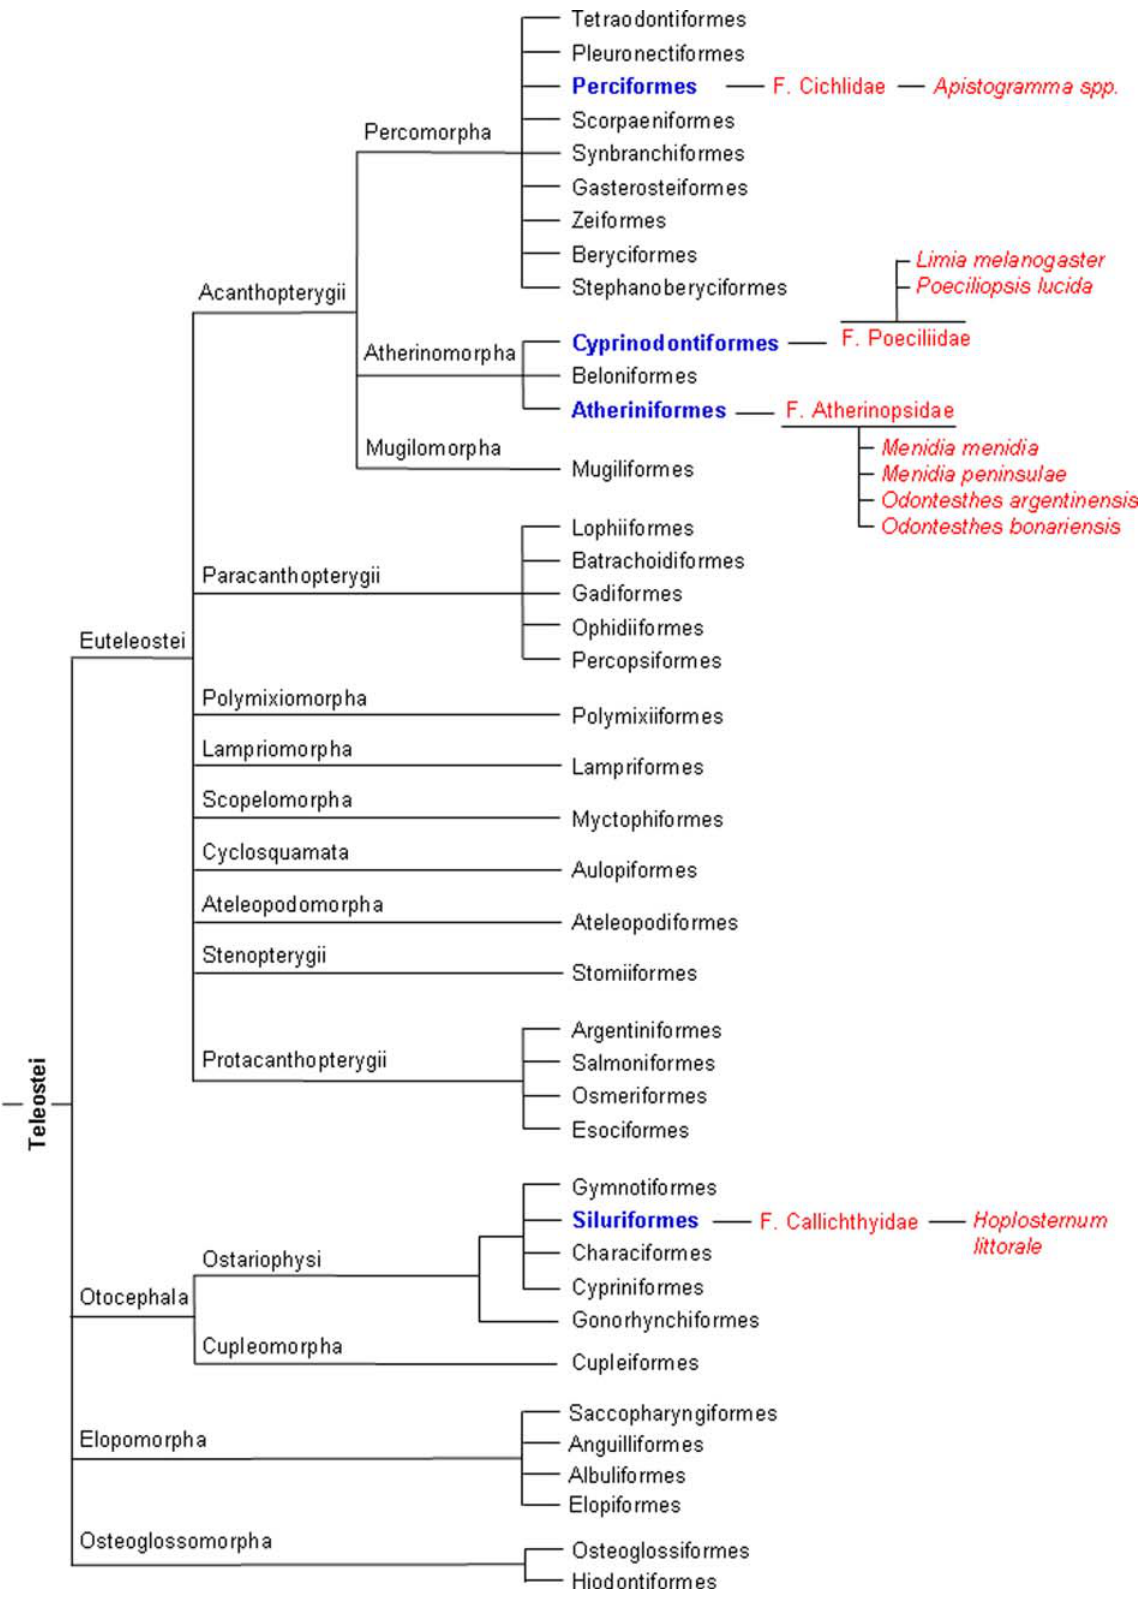
Figure 5. Distribution of temperature-dependent sex determination (TSD) in fish. Orders, families and species with TSD are marked in color. Teleost phylogeny based on Nelson [41].